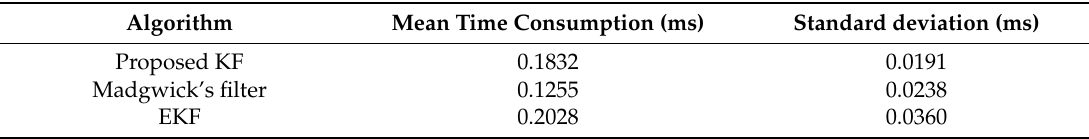
Table 5. Computational time of the proposed KF, Madgwick’s filter and EKF.